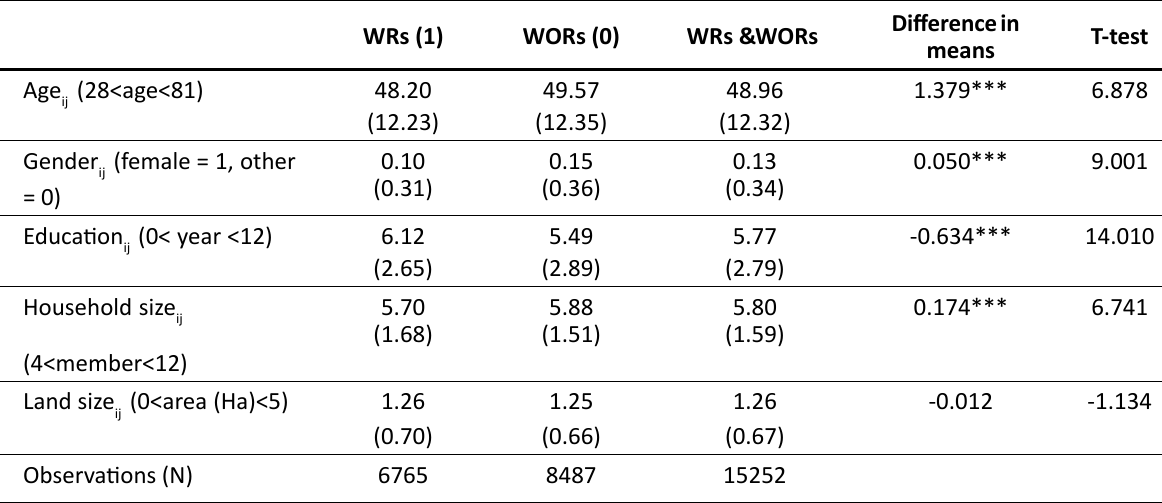
Table 2: Summary Statistics by Remittance Status - Characteristics of a Pair of Household Trades Each Other,